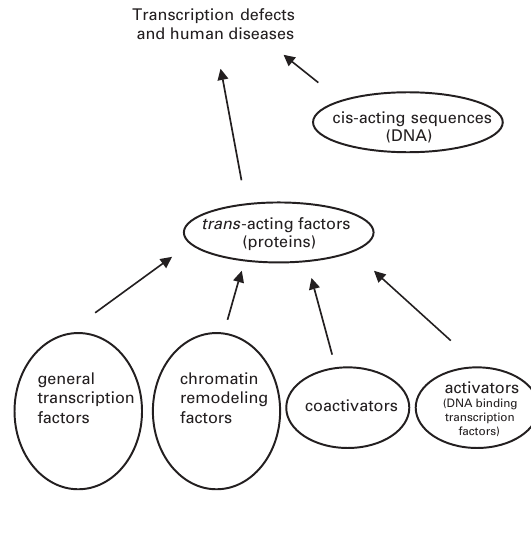
Figure 2 Transcription regu- lation defects and human disorders. A compilation of components that can be affected in muta- tions is